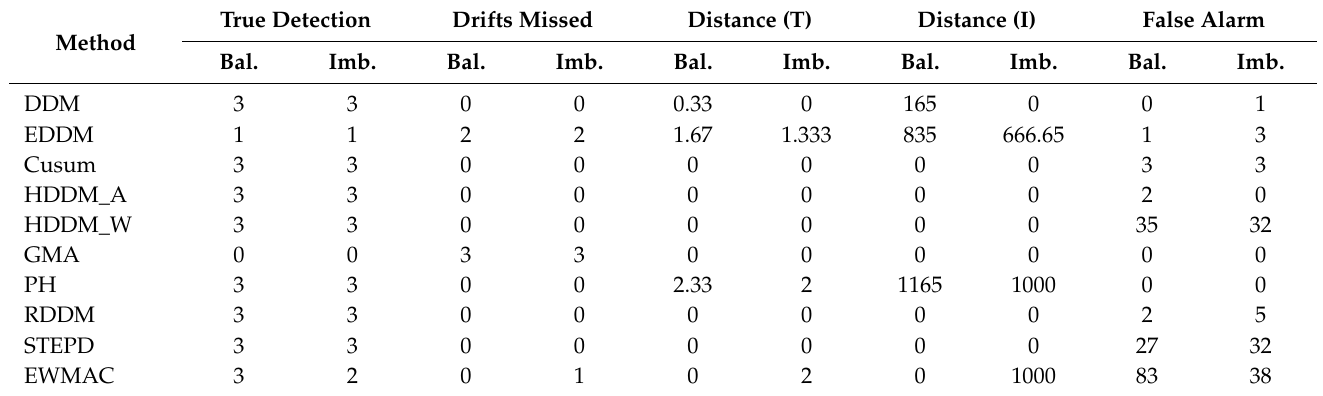
Table 4. Performance comparison on other